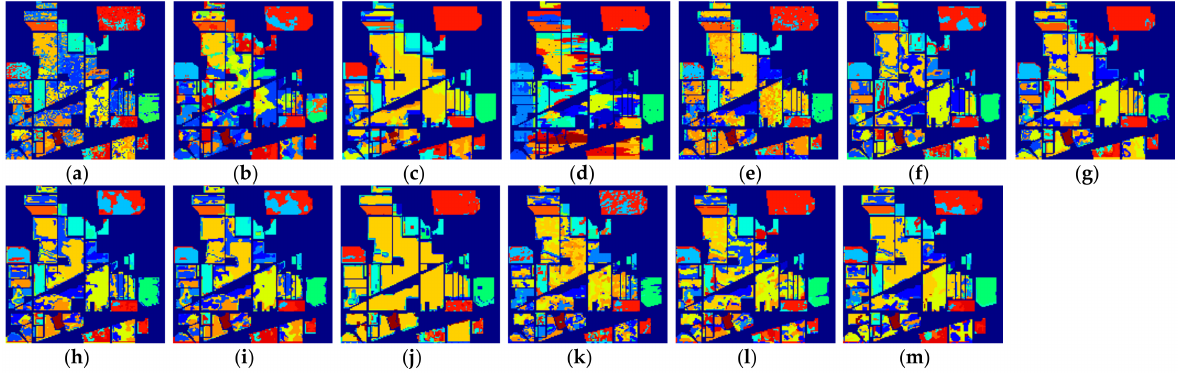
Figure 12. The classification maps of all methods with five samples on Indian Pines dataset. ( a ) SVM; ( b ) SS-LapSVM; ( c ) 3D-DENSEnet; ( d ) 3D-Gan; ( e ) SS-CNN; ( f ) 3D-CNN; ( g ) 3D-CNN k - means ( h ) 3D-CNN ours ; ( i ) 3D-CNN hardlabel ; ( j ) SSRN; ( k ) SSRN k - means ; ( l ) SSRN ours ; ( m ) SSRN hardlabel